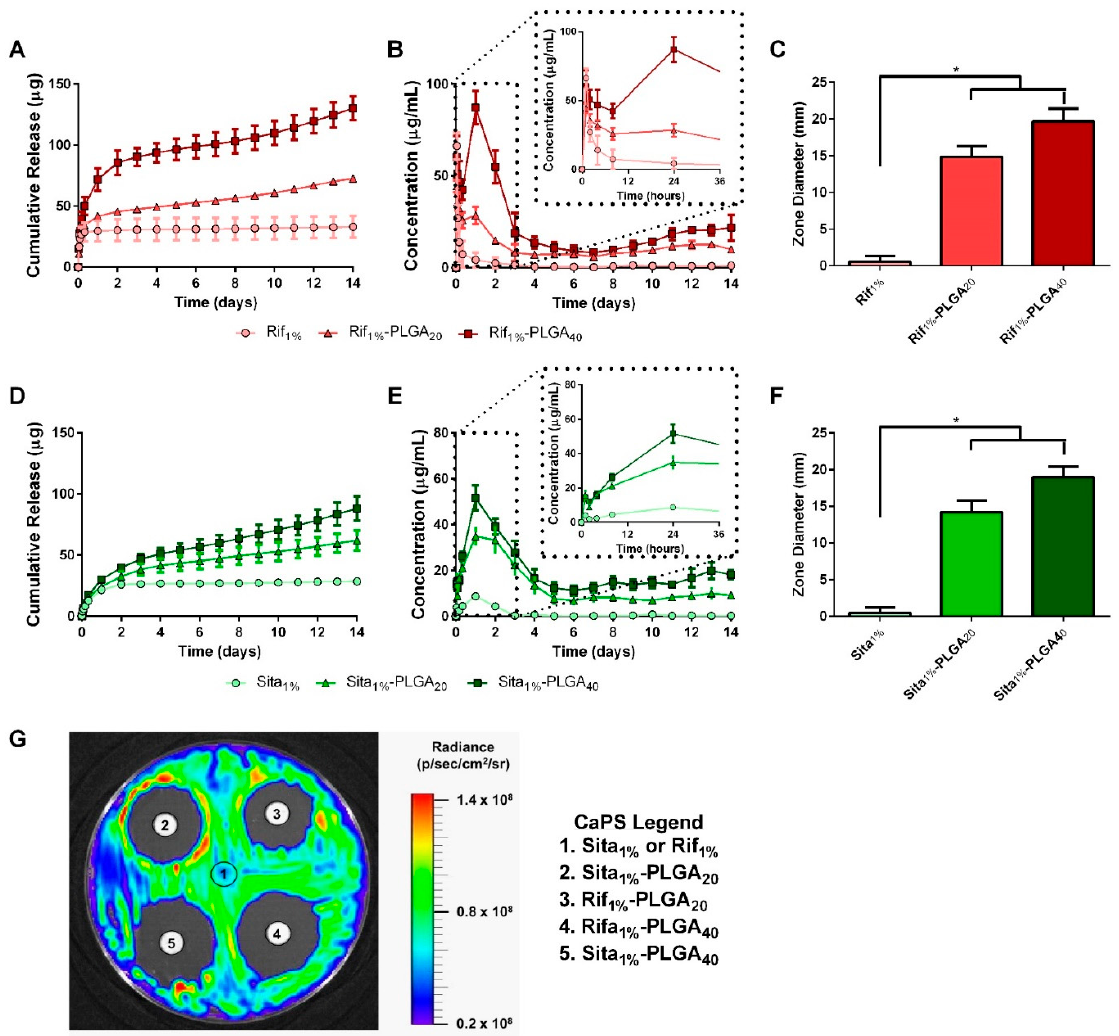
Figure 3. Drug elution kinetics of rifampin- and sitafloxacin-impregnated calcium phosphate scaffolds (CaPS) with PLGA coating. Sitafloxacin and rifampin release profiles were assessed after immersion in PBS for up to 2 weeks ( n = 5/group). ( a , b , d , e ) Bare scaffolds incorporated with either rifampin (Rif 1% ) or sitafloxacin (Sita 1% ) demonstrated a bolus release within the first 12 h succeeded by no measurable drug concentration by day 3. Coating CaPS with PLGA containing either 20 mg/mL (Sita 1% -PLGA 20 ) or 40 mg/mL (Sita 1% -PLGA 40 ) of drug enabled a biphasic release profile. Initial burst peaking in concentration at 24 h was followed by sustained release exceeding 2 weeks. Drug eluted PBS samples were taken at day 14 to qualitatively and quantitatively measure bioactivity after 2 weeks elution. Eluate was adsorbed overnight by filter paper disks and then placed on a bacterial lawn of Xen36. ( g ) All PLGA coated groups had a distinct zone of inhibition while bare scaffolds had no observed zones. ( c , f ) Quantified diameters around the disks significantly increased in PLGA coated groups in comparison to the bare CaPS. n = 5/group. * indicates p < 0.05 vs. Sita 1% or Rif 1% by Dunnett’s post-hoc after ANOVA. Data represented as mean ± standard deviation.